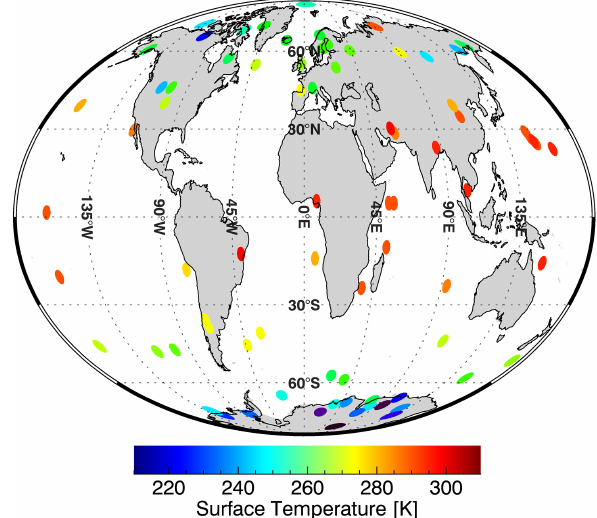
Figure 4. Sampling locations of the 80 atmospheres comprising the RTTOV training ensemble colour coded according to the atmo- spheric surface temperatures of the